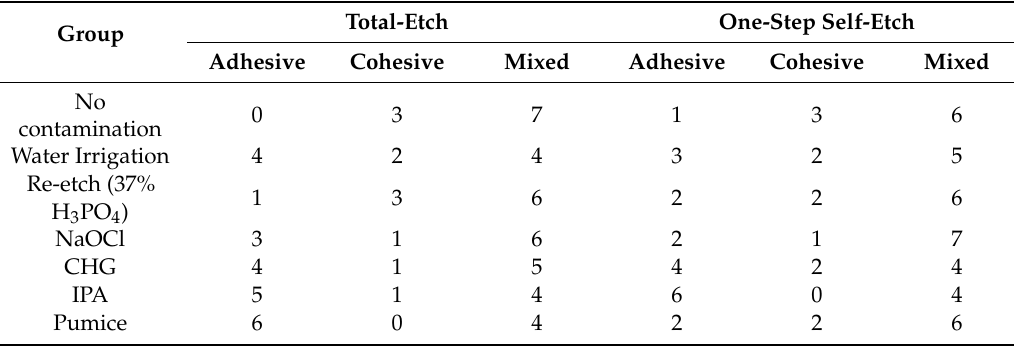
Table 6. Fracture mode recorded for each group (in